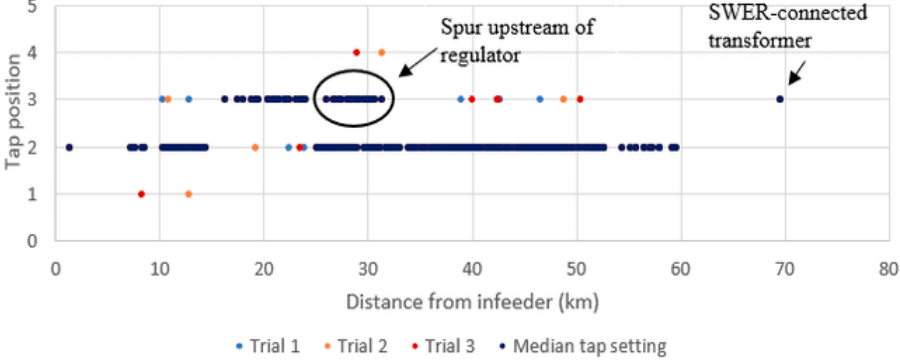
Figure 17. Transformer tap setting against electrical distance from the infeeder for Case 3. The median set of taps produced the lowest objective function and is, therefore, deemed the optimal set.